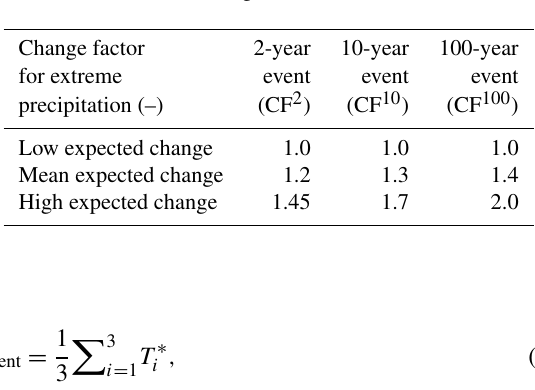
Table 3. Expected changes in extreme precipitation for Denmark. All values from Table 1 of Gregersen et al.